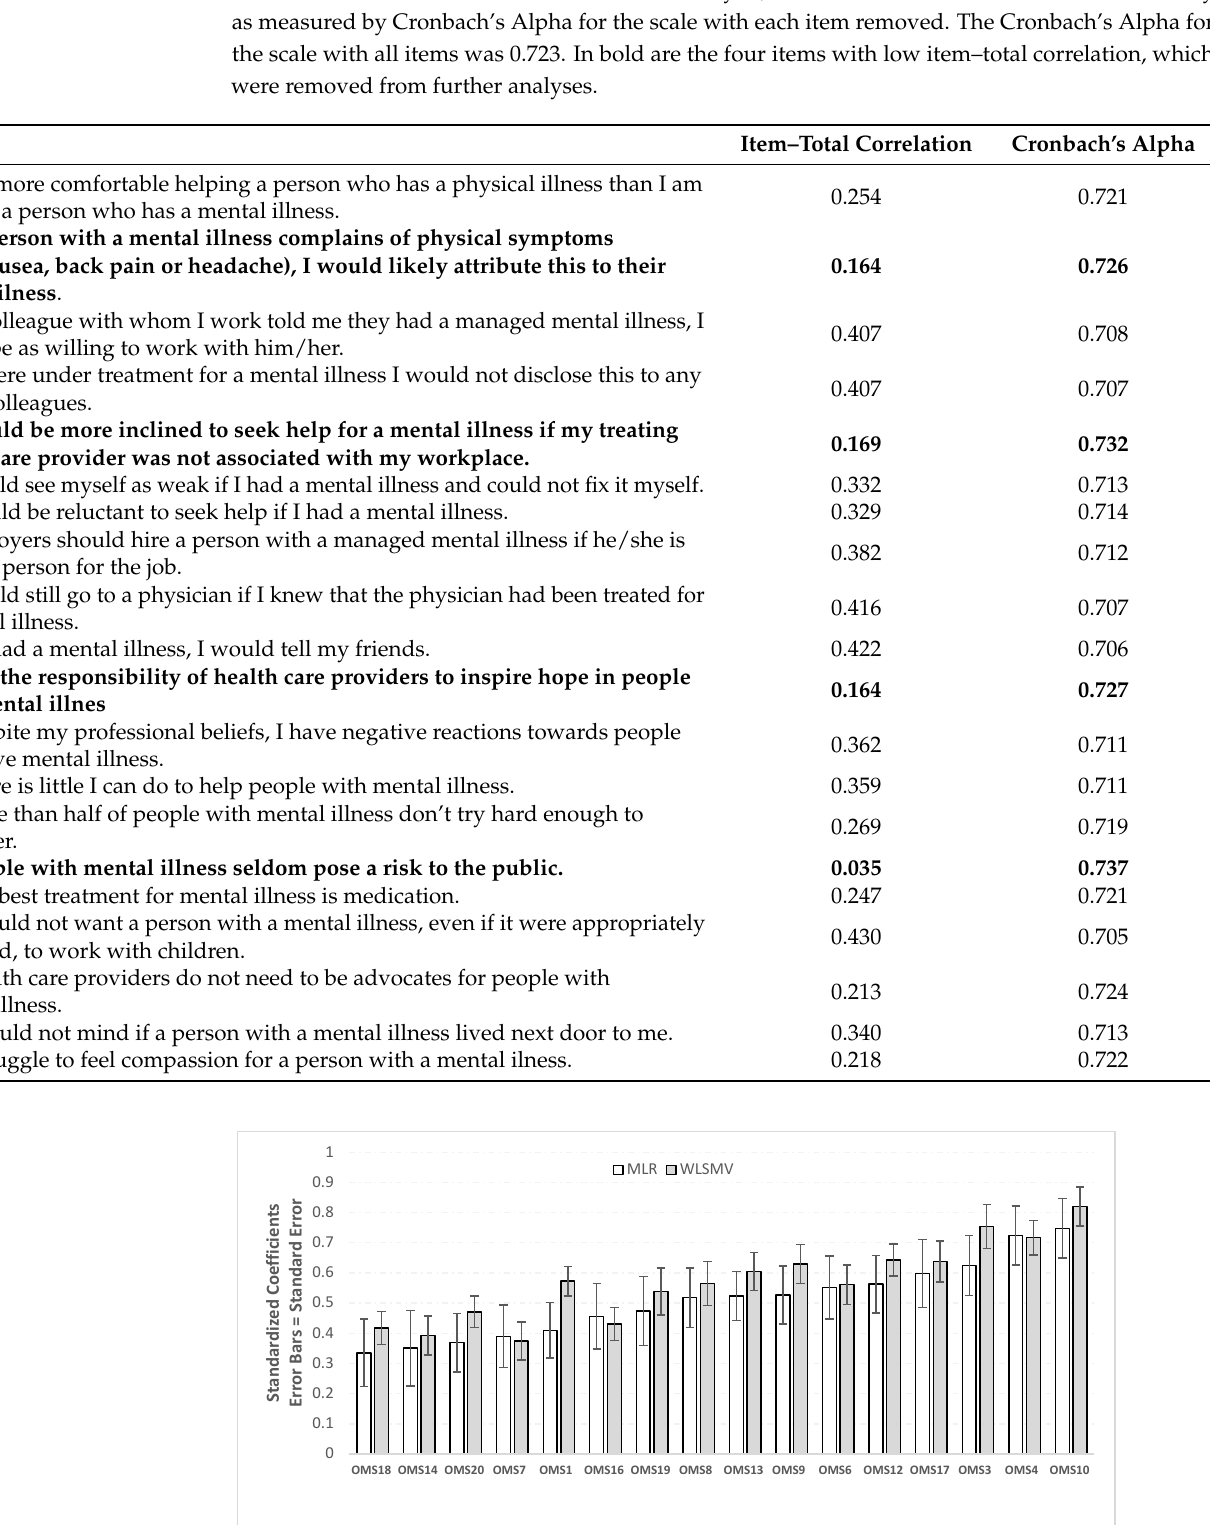
Figure A2. Path diagram for the bifactor model. The general factor “g1” represents the general OMS construct and each of the four specific factors represents one specific subscale. The bifactor allow us to understand to what extent the properties of the latent variables are different from each other and different from the general OMS construct, as for example, if the total sum score with unit weight represents well the OMS construct, and if this specific subscale is unique. Values in the graph are standardized model coefficients (factor loadings). We removed residual variances for clarity. Appendix B. Short Explanation of Ancillary Indices That Are Calculated from the Bi- factor Model This is a brief explanation of the indices reported in this manuscript. We recommend [8] for a more complete overview of the use of bifactor model and derived metrics in the psychometric analysis of properties of scales.